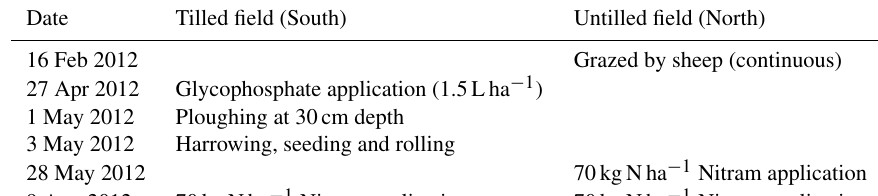
Table 1. Field management events for both the tilled and untilled fields in 2012.